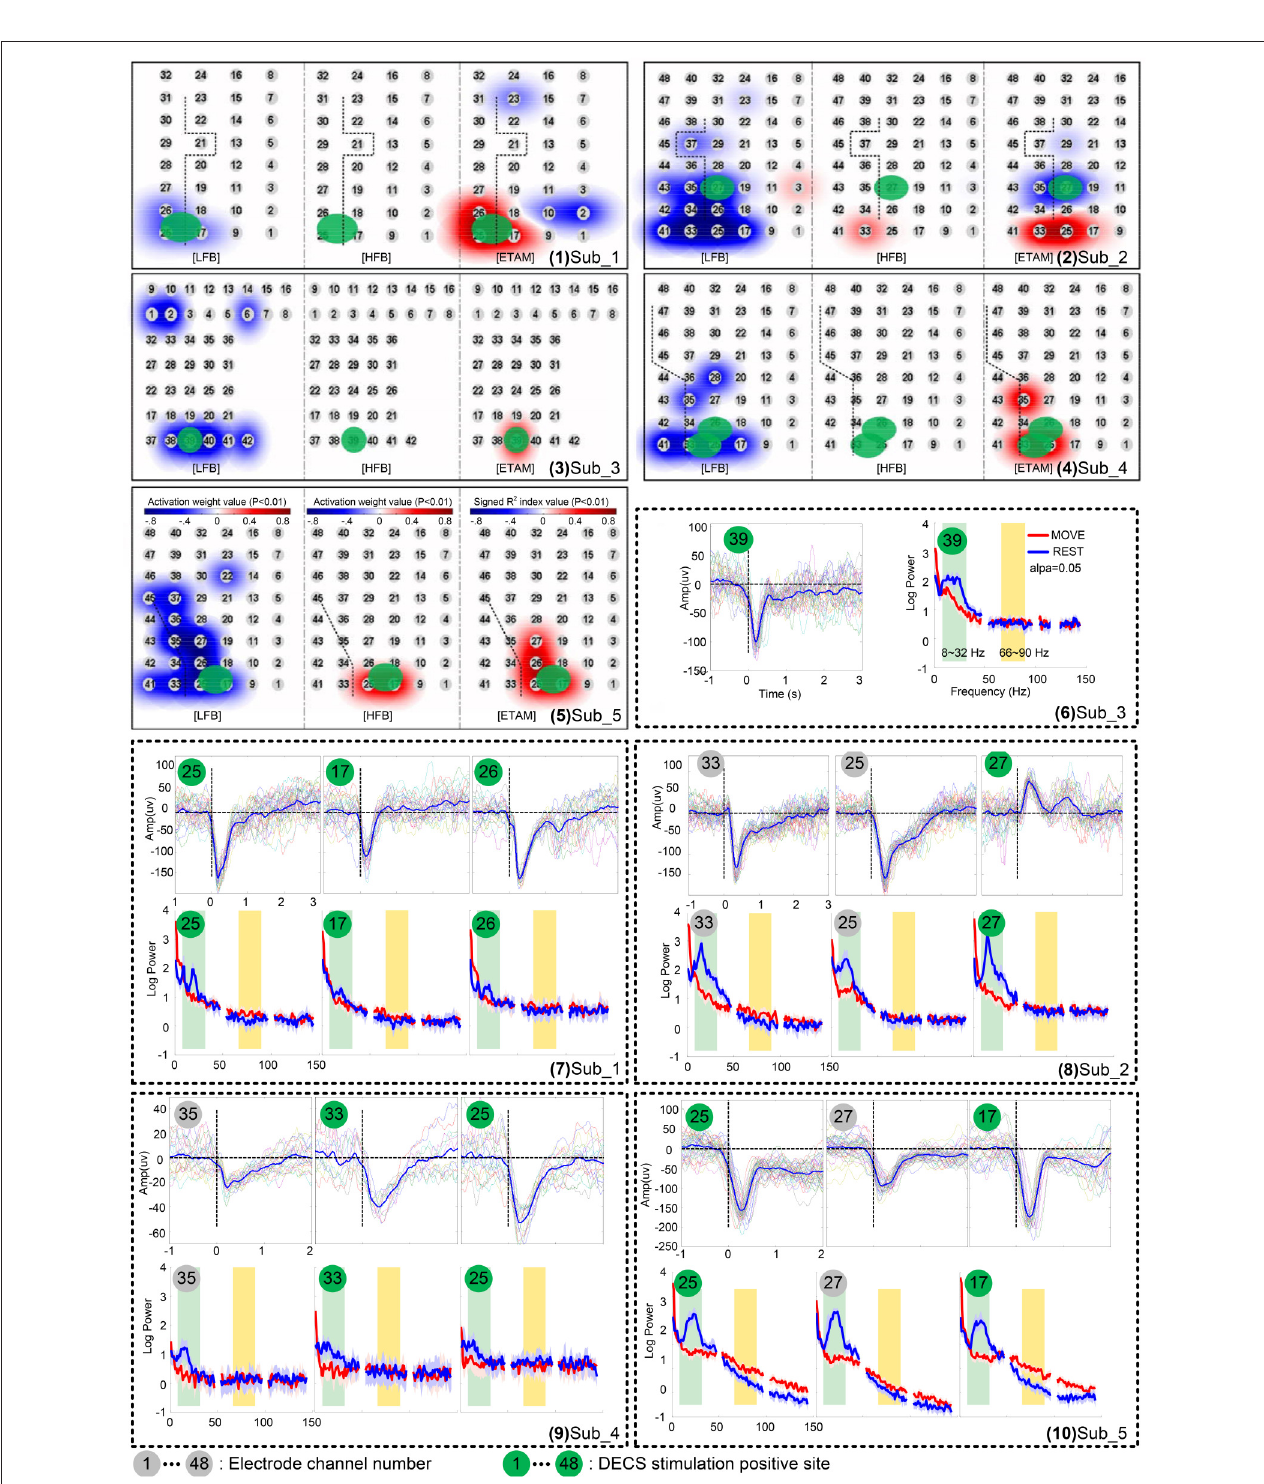
FIGURE 3 | Cortical activation for wrist extension motion during awake craniotomy of five subjects. (1–5) topographic distribution maps. Electrode locations are signed in numbers with a gray cycle. For each subject, the left panel is the low frequency band (LFB) results, middle panel is the high frequency band (HFB) results, and the right panel is the ETAM results. (6–10) comparison of movement-related cortical potentials (MRCPs), low frequency band (LFB, 8–32 Hz) spectral alteration, and high frequency band (HFB, 66–90 Hz) spectral alteration. Electrode numbers with green cycle indicated DECS-positive electrodes.